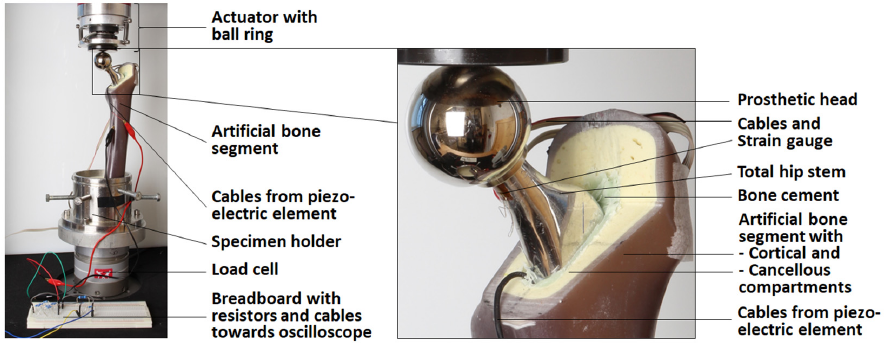
Figure 3. Test setup of the full system with detailed view of the implant (only the actuator of the testing machine is shown; other equipment is described in the text).